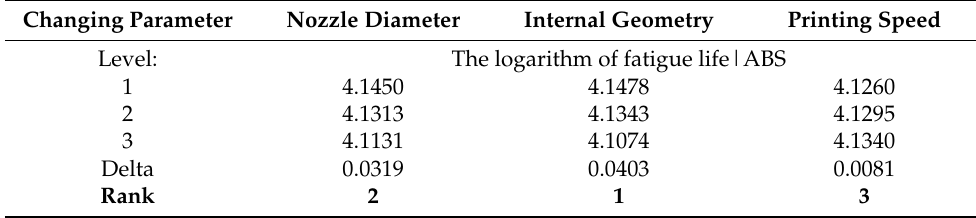
Table 6. The comparison of mean values of data according to their categories and ranking of parameters for ABS and Nylon materials.